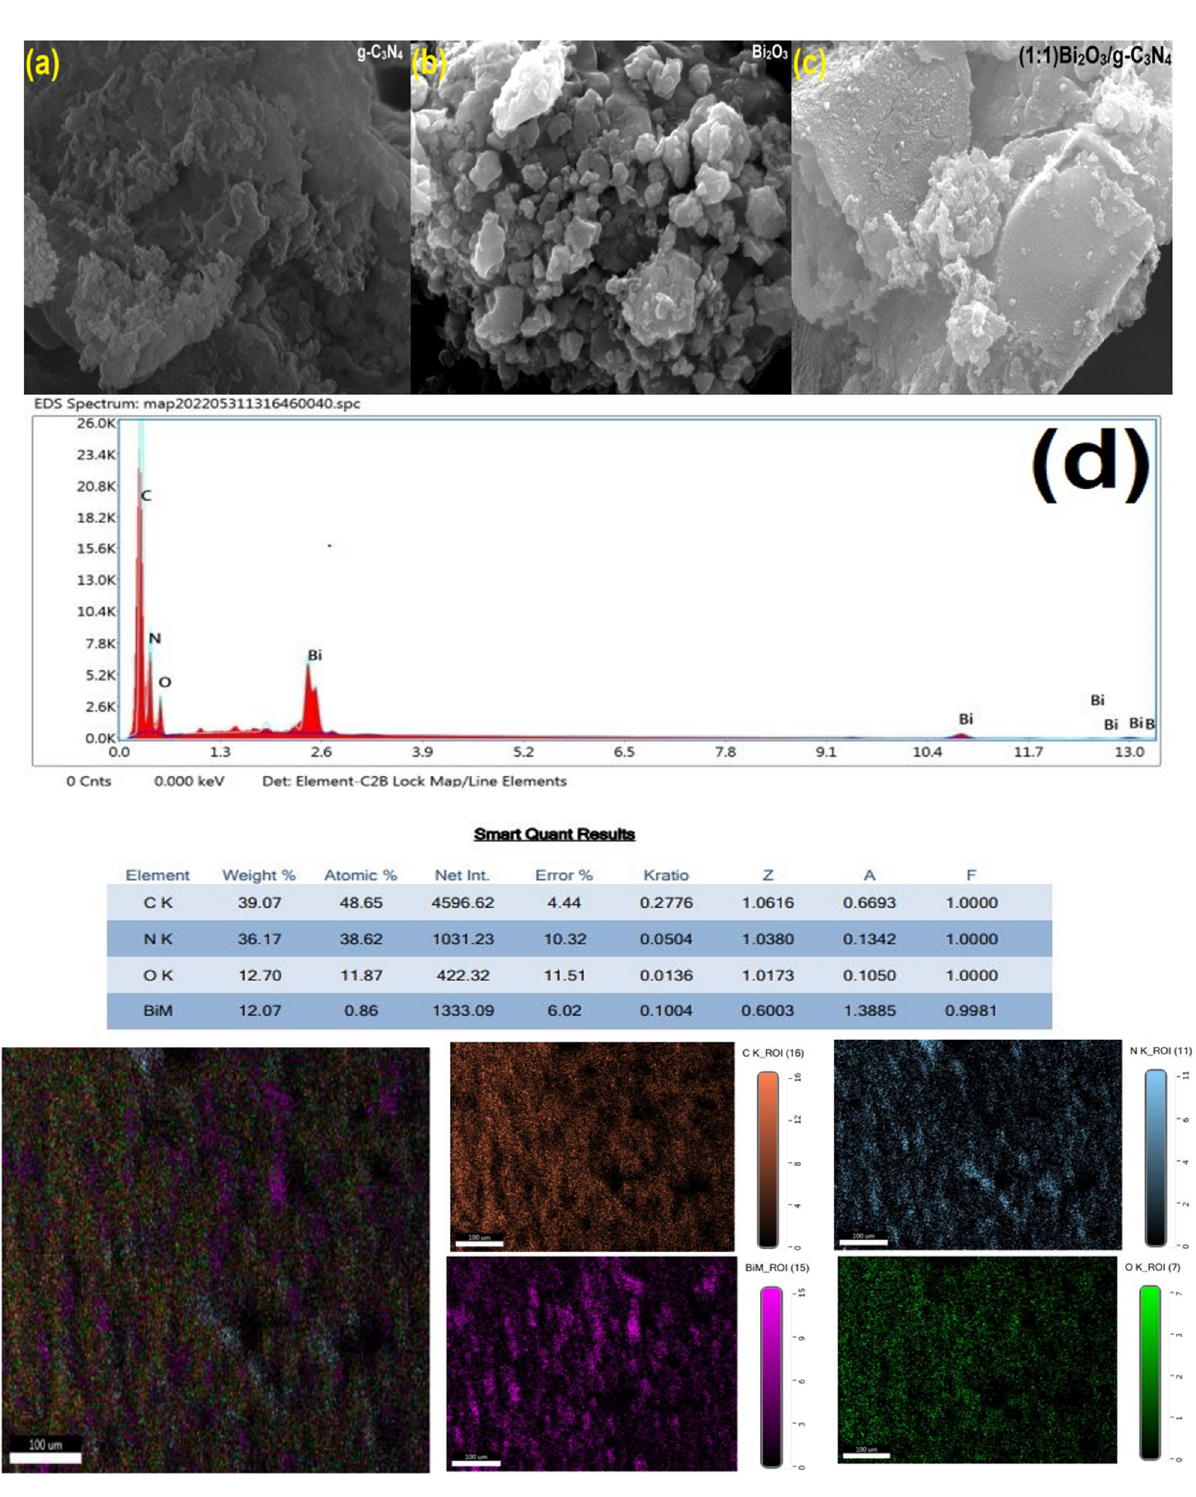
Figure 2. SEM image of ( a ) g-C 3 N 4 , ( b ) Bi 2 O 3 , ( c ) 1:1 Bi 2 O 3 /g-C 3 N 4 ; ( d ) EDS spectrum/elemental mapping of 1:1 Bi 2 O 3 /g-C 3 N 4 nanocomposite.